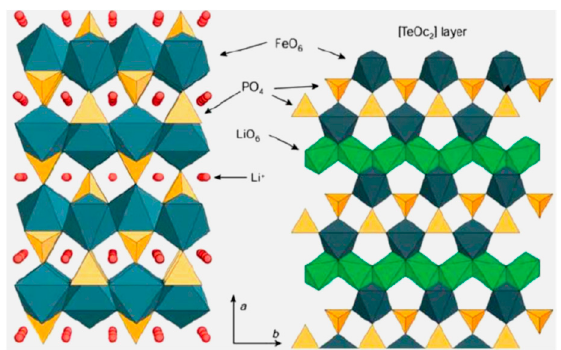
Figure 2. The crystal structure of olivine LiFePO 4 . Adapted with permission from Ref [27]. 2001, Springer Nature.